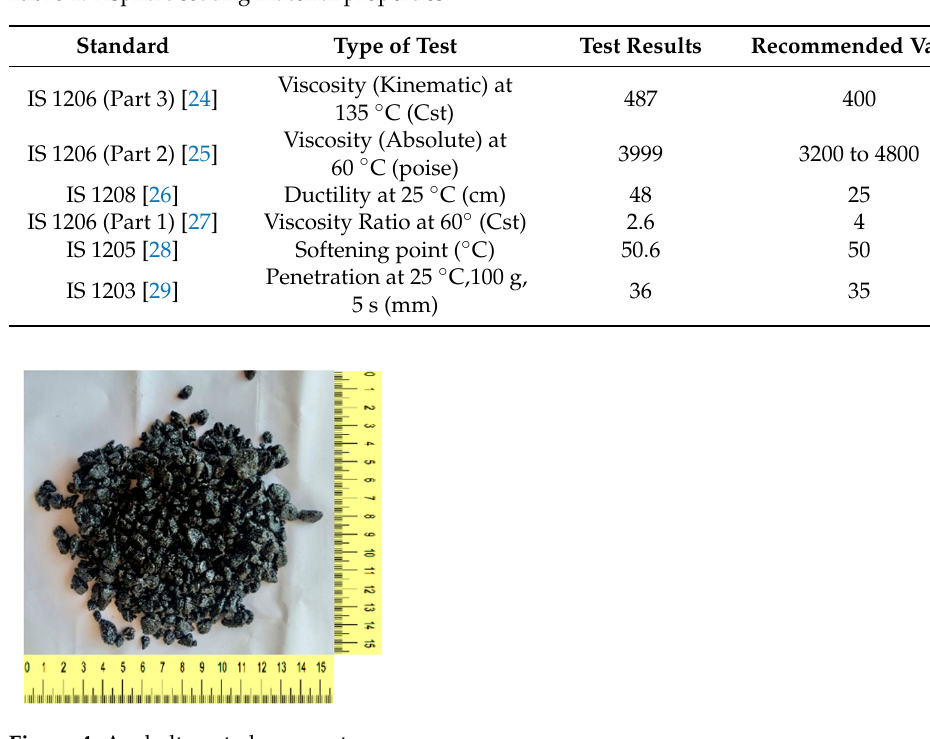
Figure 3. Shape of fibres ( a ) PF ( b ) SF. Table 1. Asphalt coating material properties.